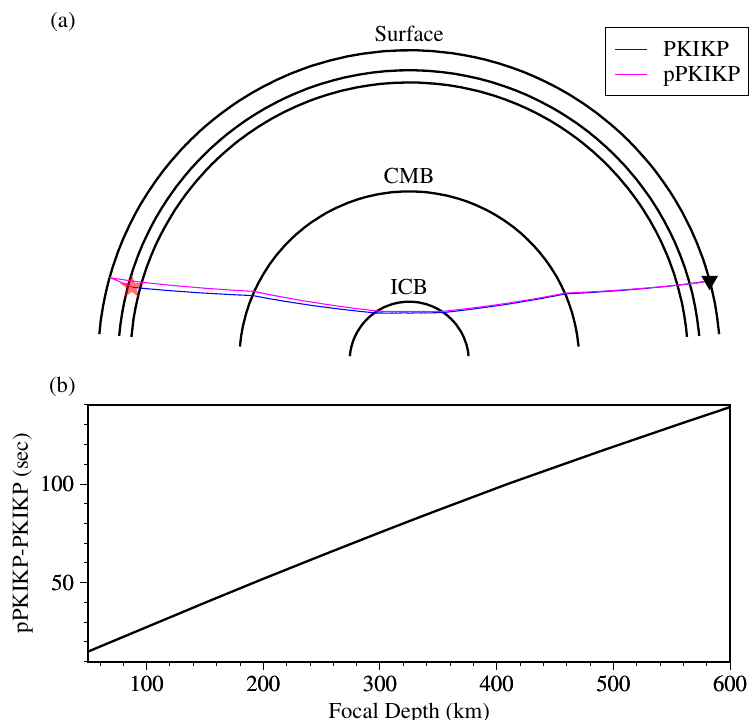
Figure 1. ( a ) Schematic diagram showing seismic ray paths of PKIKP (blue line) and pPKIKP (magenta line), traveling from the source (red star) to a station at the Earth’s surface (black triangle), CMB and ICB represent core-mantle boundary and inner-core boundary, respectively. ( b ) Relationship between theoretical pPKIKP-PKIKP time interval and focal depth at the epicenter distance